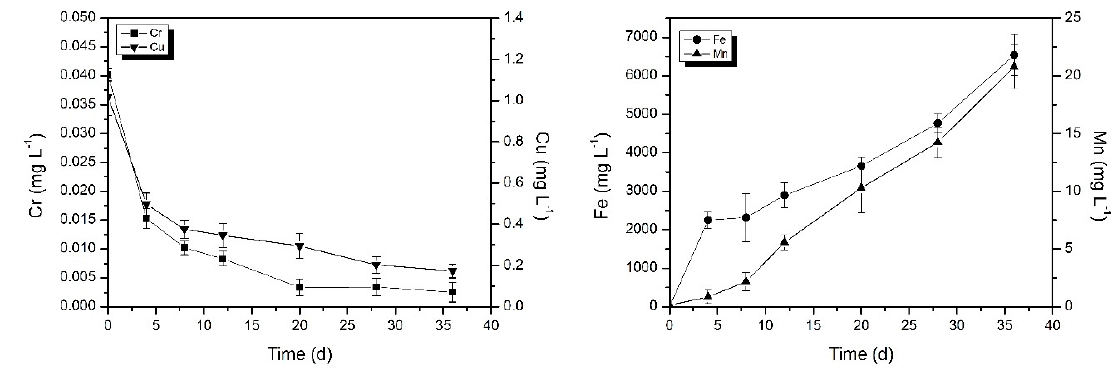
Figure 3. Change in copper, chromium, iron, and manganese mean concentrations in occluded water. Error bars indicate ± standard deviation.